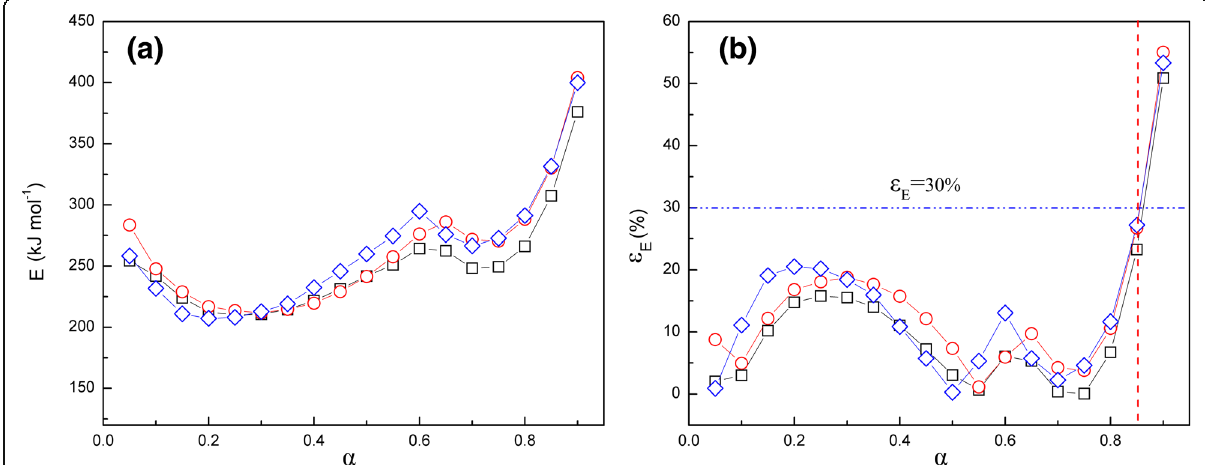
Fig. 2 ( a ) Activation energy calculated by FWO, MKAS, and FR methods; ( b ) absolute deviation ( ε E ) vs.